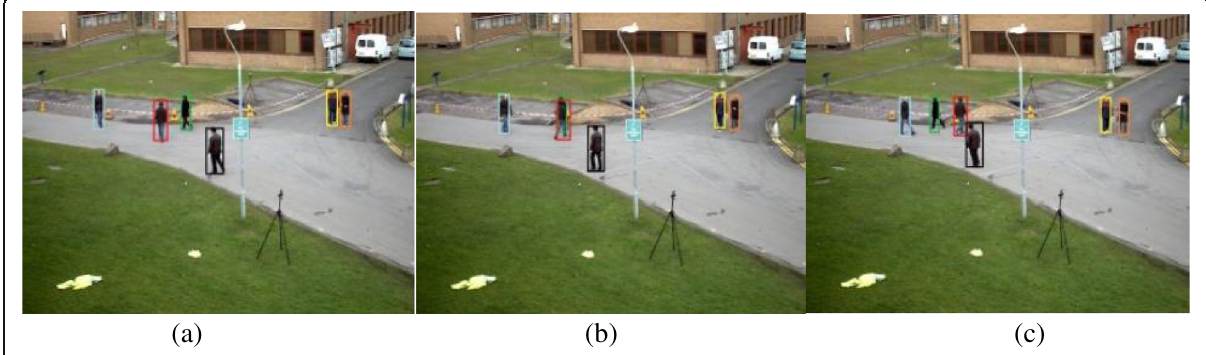
Fig. 6 Illustration of tracking multiple human targets in an outdoor scene. a Human targets tracked with different color rectangle bounding boxes. b Two human targets tracked successfully under fully mutual occlusion with a red/green rectangle bounding box. c Two human targets split correctly after fully mutual occlusion with a red/green rectangle bounding